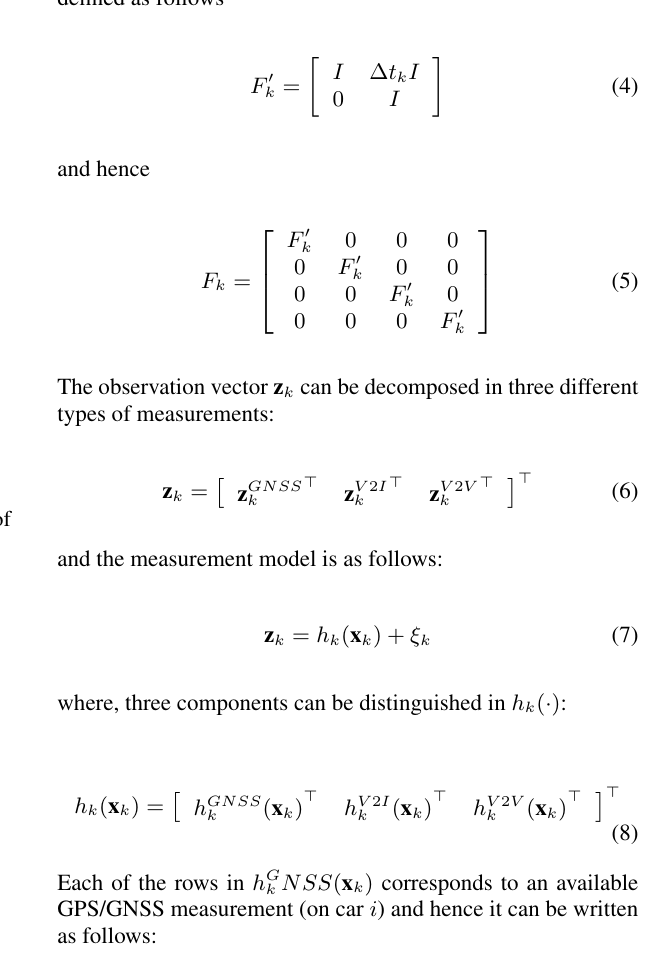
Figure 11. V2I TimeDomain ranging error